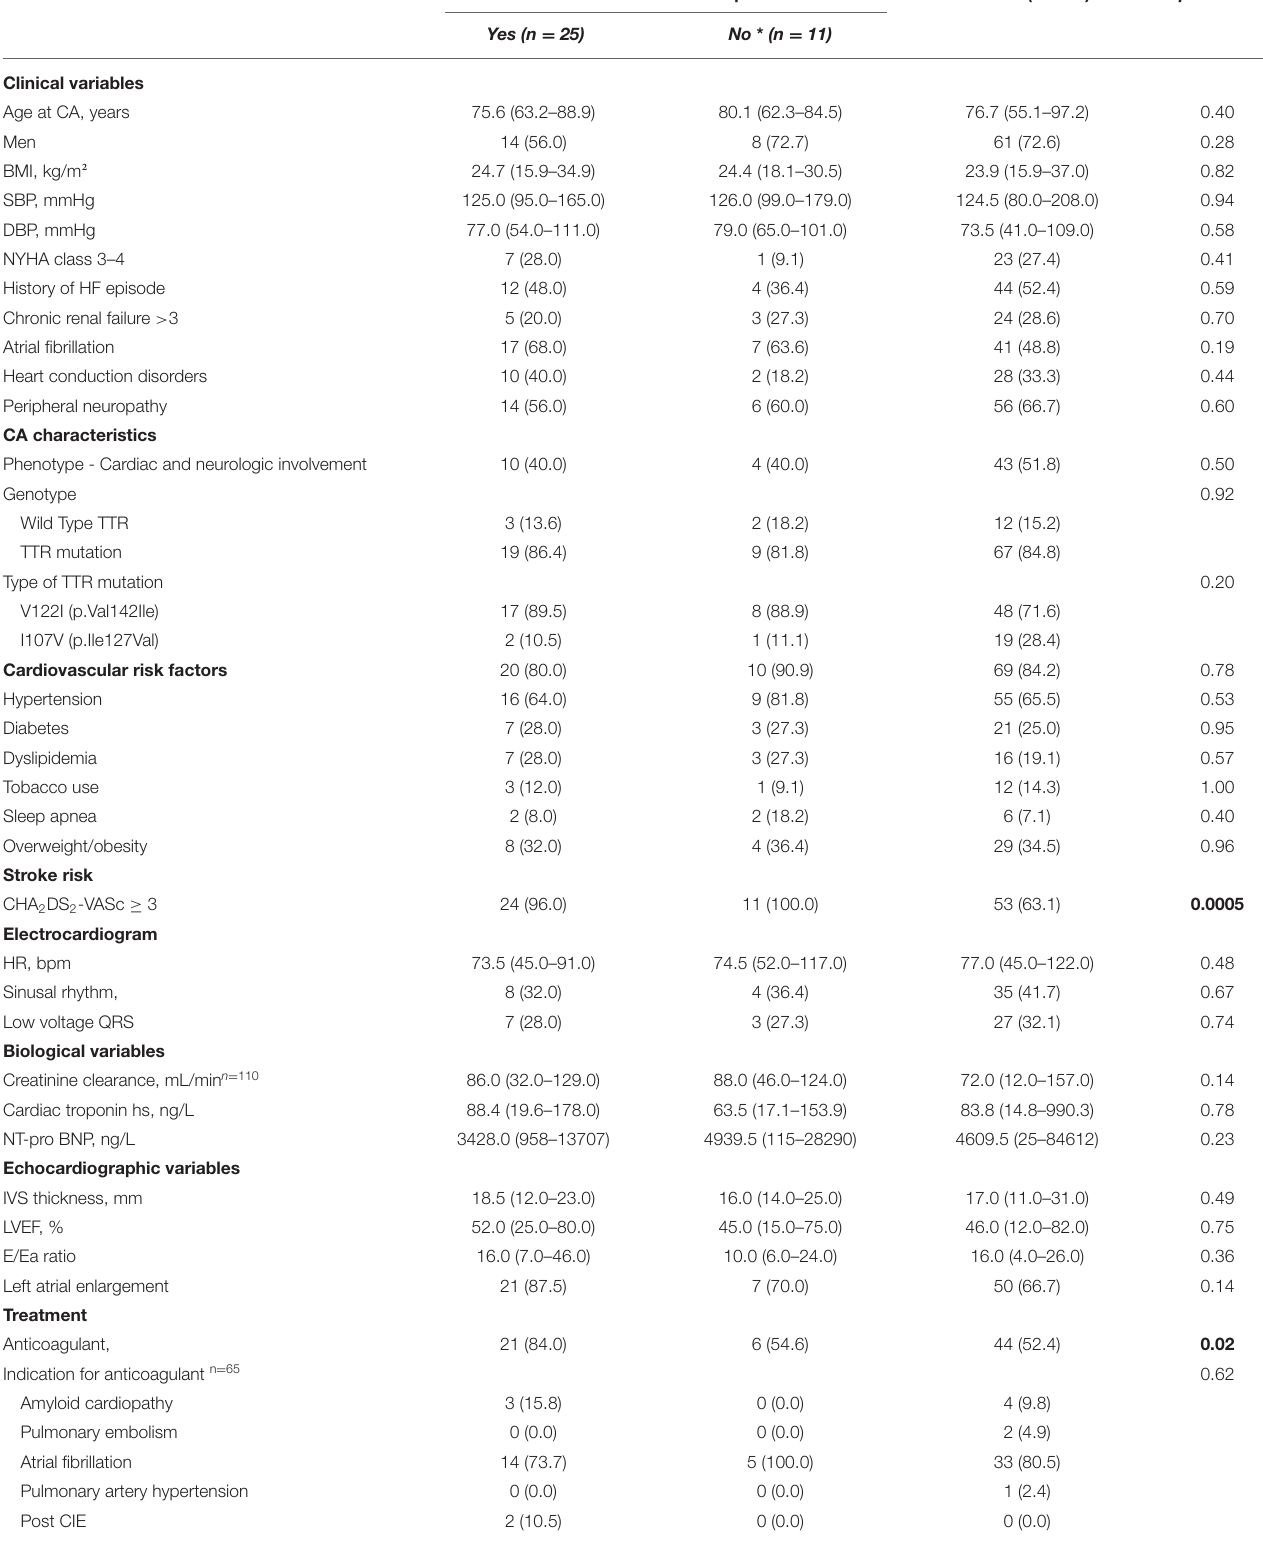
TABLE 3 | Clinical characteristics of the study population ( N = 120) according to presence of Cerebral Ischemic events (CIE).